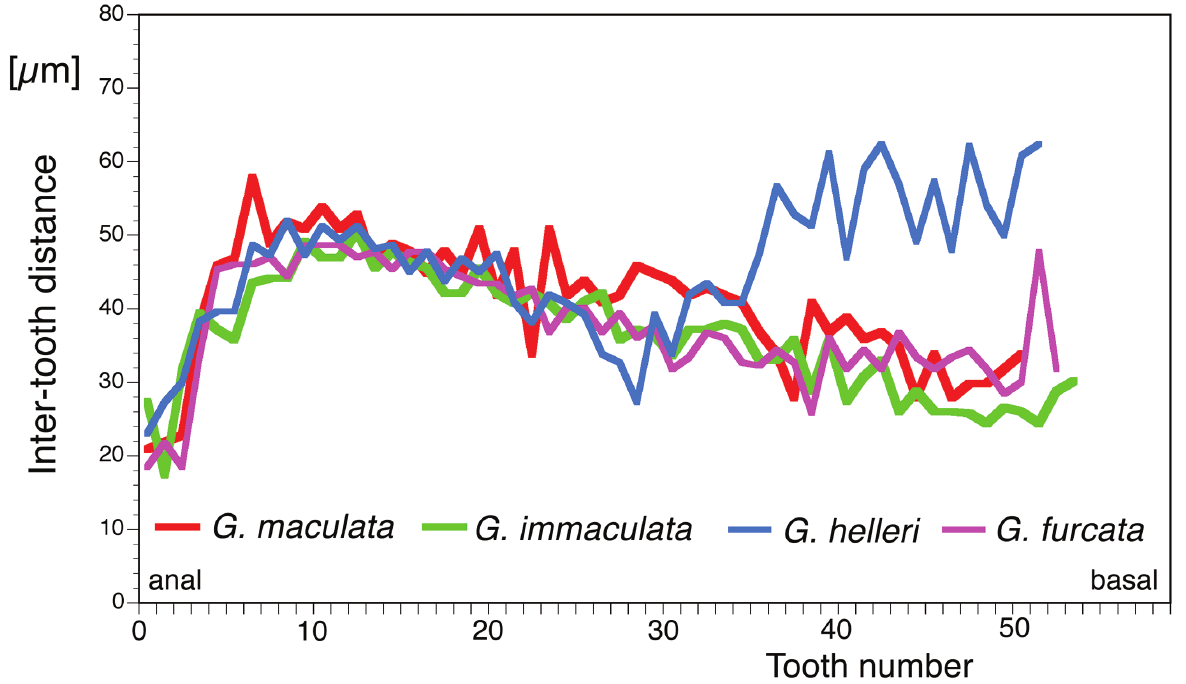
Figure 19. Inter-tooth spacing in stridulatory files of male Gonatoxia species (most intervals between small teeth at the anal end not